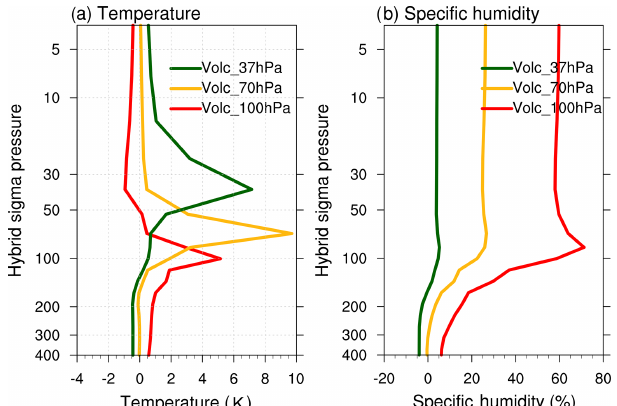
Figure 8. Vertical profiles of changes in global and annual mean of stratospheric (a) temperature and (b) specific humidity in percent- age for the stratospheric sulfate simulations relative to the 2XCO2 experiment (slab ocean simulations). Lines are linear interpolations between layer midpoint